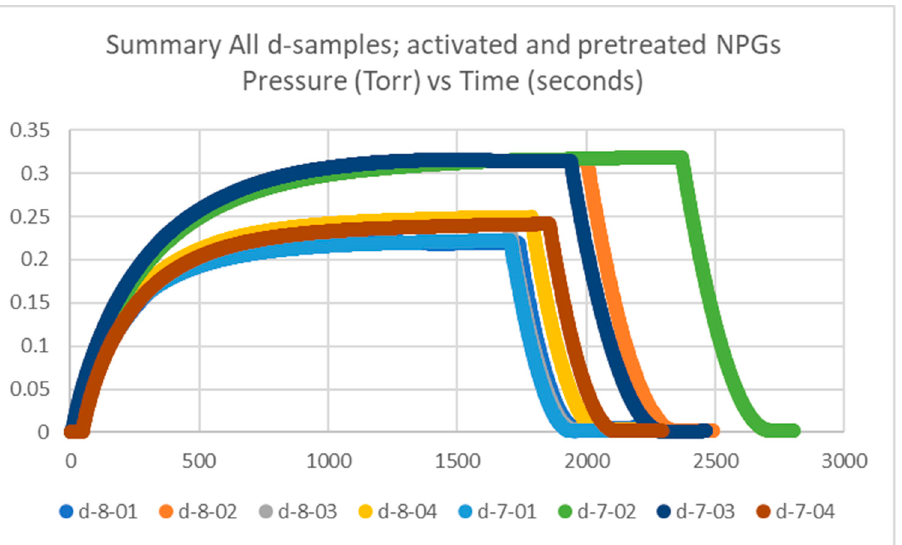
Figure 2. Summary of getter rate tests for all NPG d-samples (getter tubes 7 and 8; pretreated and activated getters) with pressure in Torr vs. time in seconds. activated getters) with pressure in Torr vs. time in